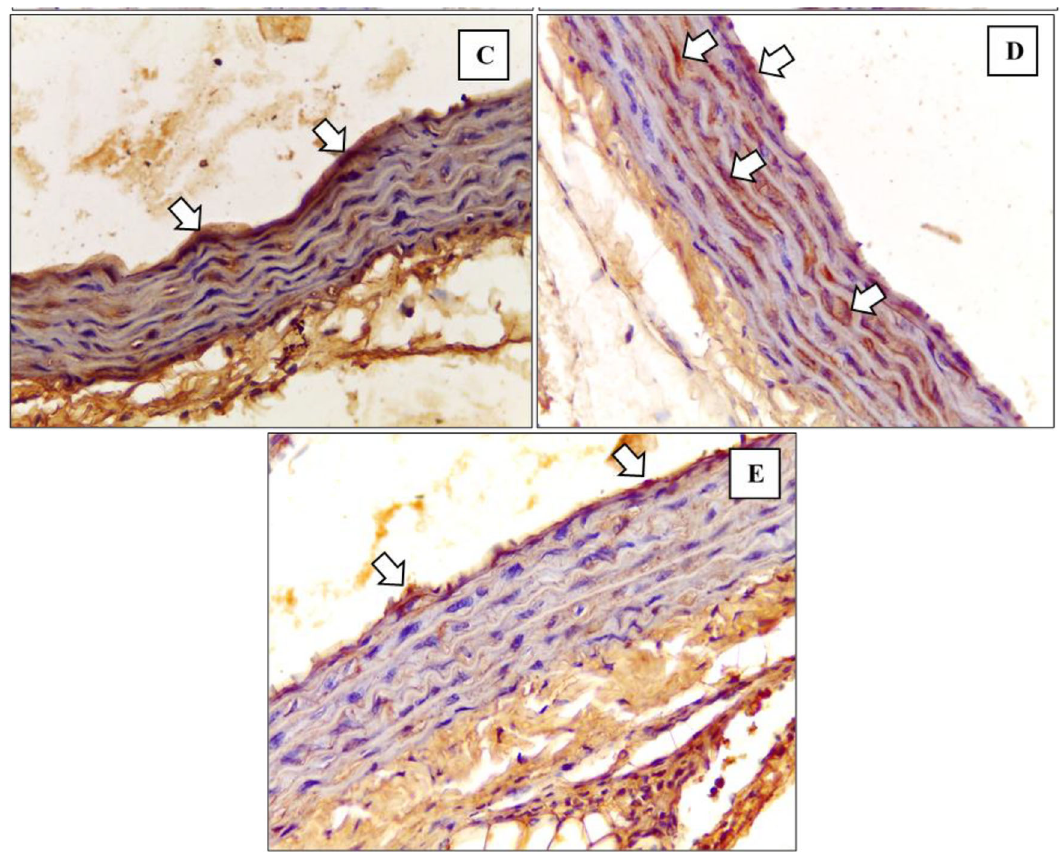
Figure 6. Immunohistochemical staining of M2 expression by Egr-2 (white arrow) at (C) P1 (D) P2 ( E) P3.